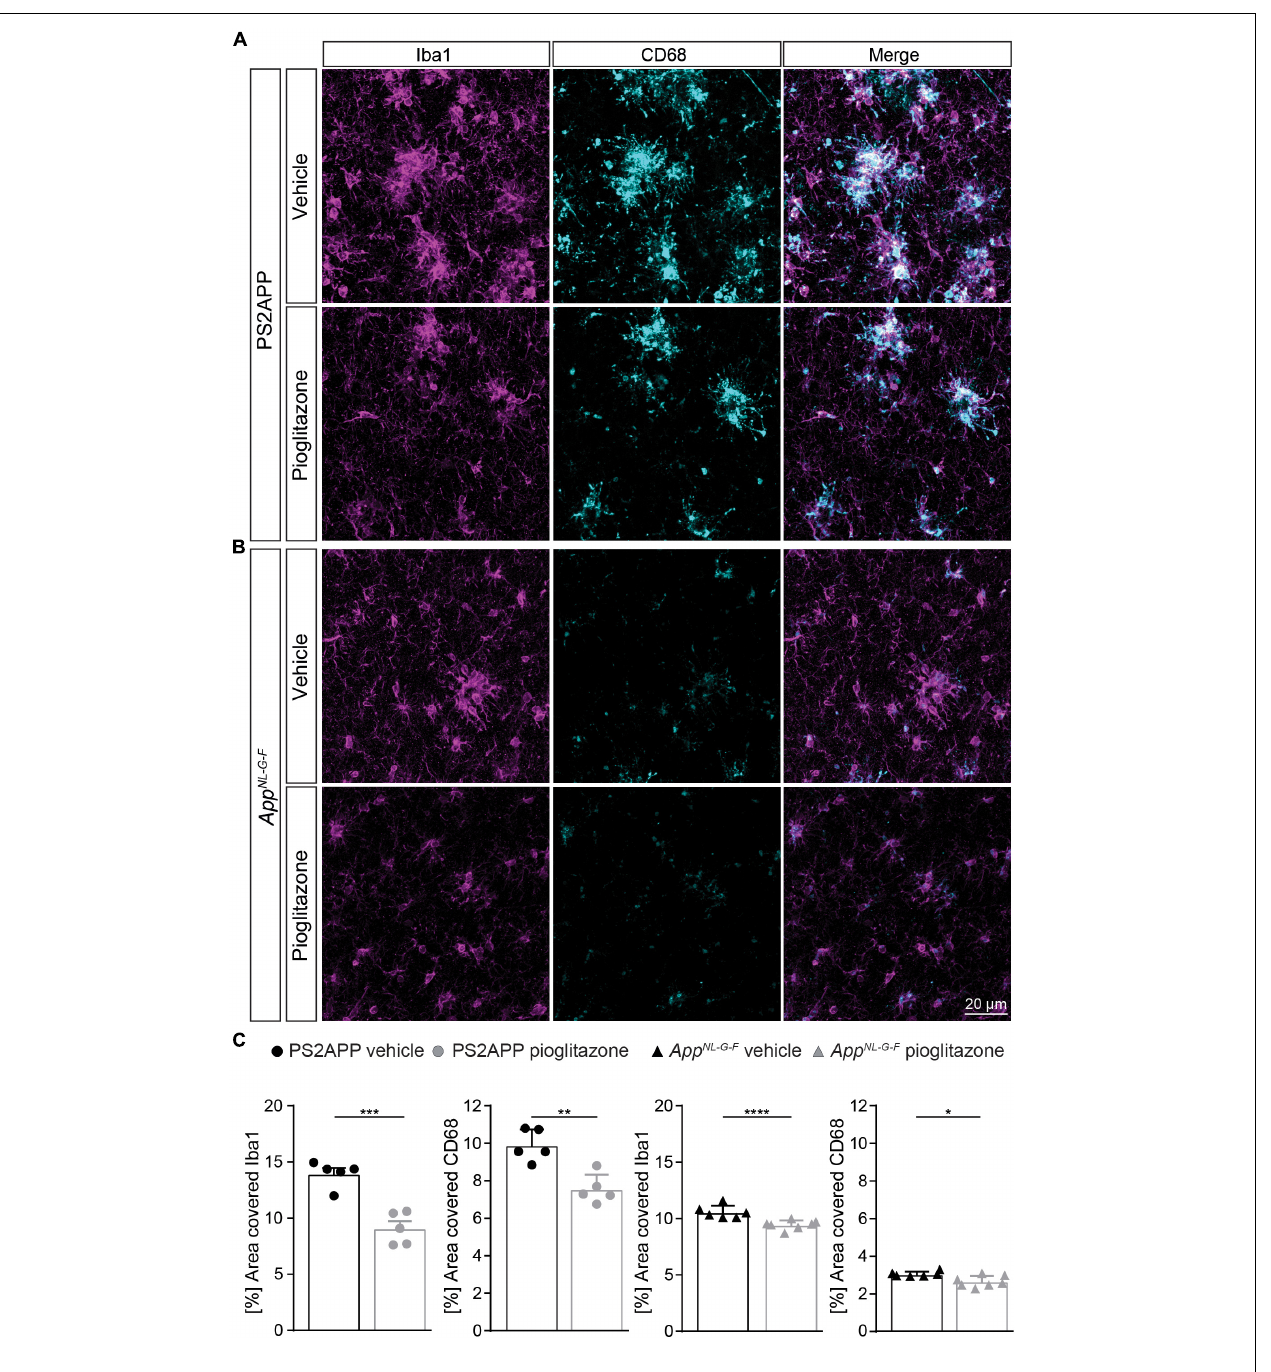
FIGURE 4 | Pioglitazone treatment reduces microglial activation in both AD mouse models. Iba1- (magenta) as well as CD68-(cyan) positive microglial cells in PS2APP (A) and App NL - G - F mice (B) . (C) The area of Iba1 positive microglial cells [ t ( 8 ) = 5.95; p = 0.0003] as well as CD68 positive microglial cells [ t ( 8 ) = 4.58; p = 0.0018] decreased in treated PS2APP mice. The same effect was observed in App NL - G - F mice were the area covered by Iba1 positive [ t ( 11 ) = 4.21; p = 0.0015] as well as CD68 positive microglial cells [ t ( 11 ) = 2.91; p = 0.014] were significantly reduced in treated compared to untreated mice. Data are presented as mean ± SEM; n = 5–7 mice. Two-sample student’s t -test results: * p < 0.05; ** p < 0.01; **** p <